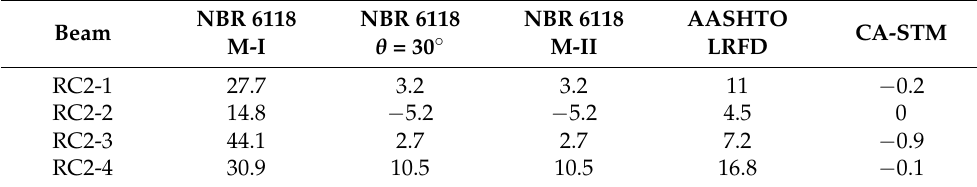
Table 3. Relative errors (%) for the maximum shear force for RC beams from Series 1.